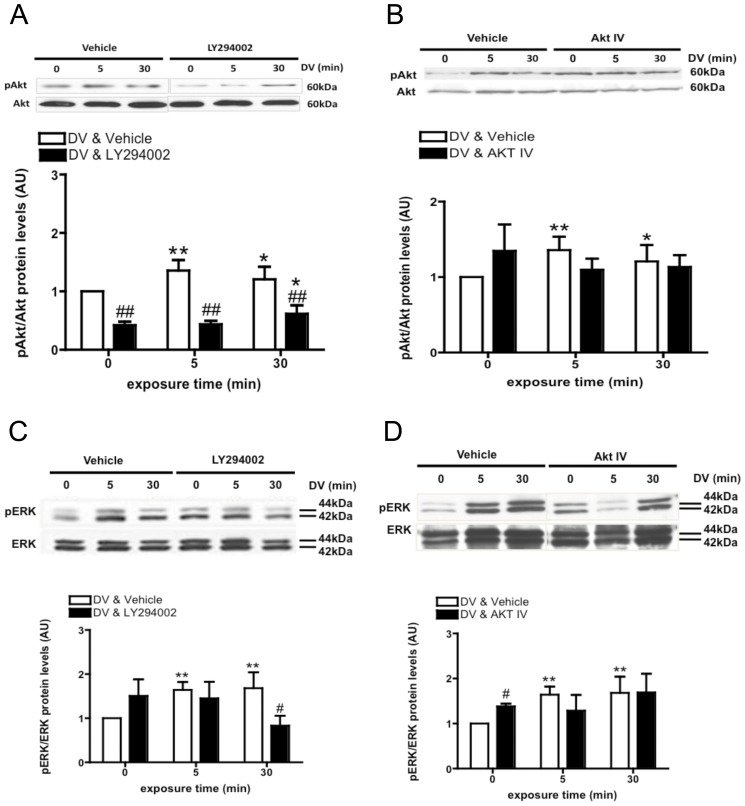
DV increases both Akt and ERK phosphorylation.(A) Immunoblots (upper) and OD quantification (lower) for phosphorylated Akt (pAkt) and pan-Akt (Akt) from BECs in the presence of DV and/or 10 µM LY294002 (PI3K inhibitor). N = 3, *P<0.05 and **P<0.01 versus 0 min timepoint, ##P<0.01 versus DV-only treated group (vehicle) (B) Immunoblots (upper) and OD quantification (lower) for pAkt and Akt in BECs treated with 10 µM AktIV (Akt inhibitor). N = 3, *P<0.05 and **P<0.01 versus 0 min timepoint. (C) Immunoblots (upper) and OD quantification (lower) for phosphorylated ERK (pERK) and pan-ERK (ERK) in BECs treated with 10 µM LY294002. N = 3, **P<0.01 versus 0 min timepoint, #
P<0.01 versus DV-only treated group (vehicle). (D) Immunoblots (upper) and OD quantification (lower) for phosphorylated ERK (pERK) and pan-ERK (ERK) in BECs treated with 10 µM AktIV. N = 3, **P<0.01 versus 0 min timepoint, #
P<0.01 versus DV-only treated group (vehicle).